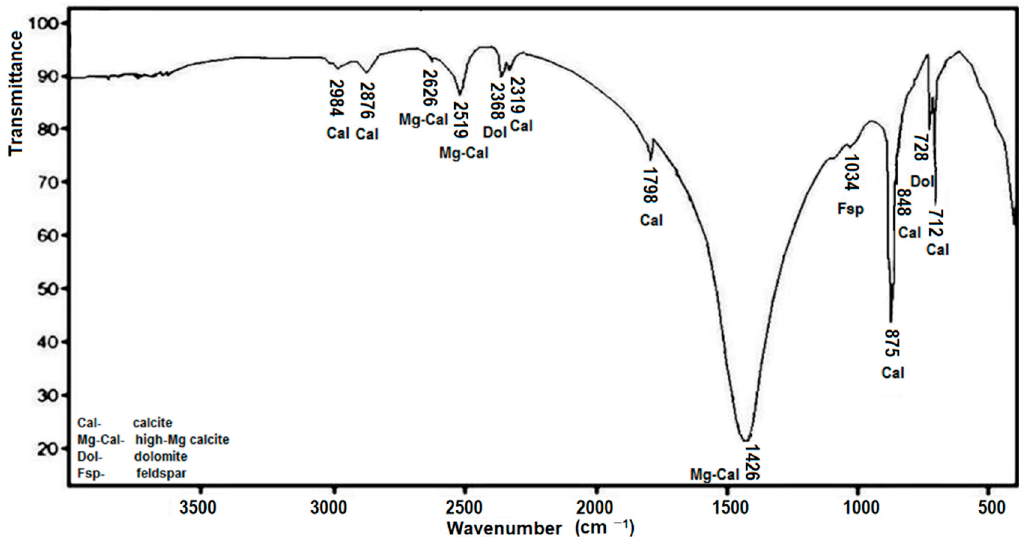
Figure 12. Infra-red absorption spectrum of sample SO14, limestone of the Karchowice Unit taken in the Strzelce Opolskie Quarry [21,22,24].